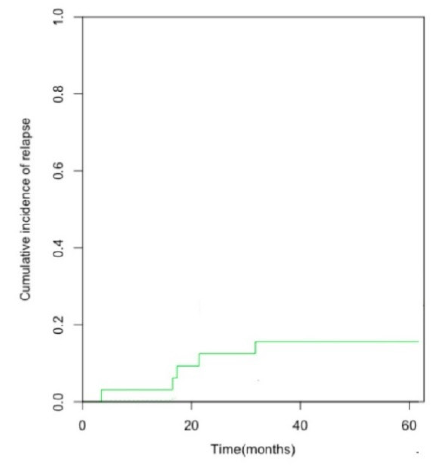
Figure 2. Cumulative incidence of relapse.